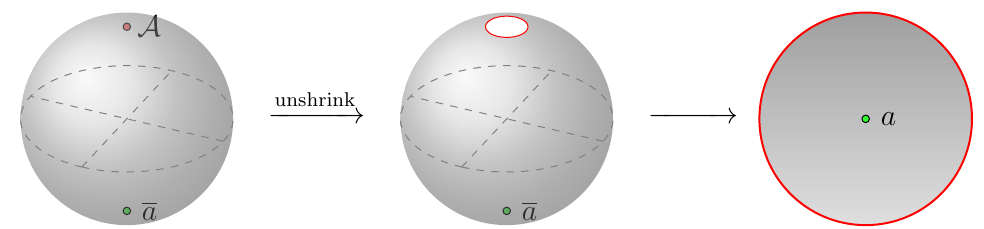
Figure 2: The anyons a and S 2 . Replacing the algebra anyon